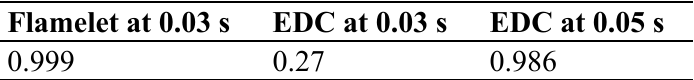
map after 0.03 s; 2